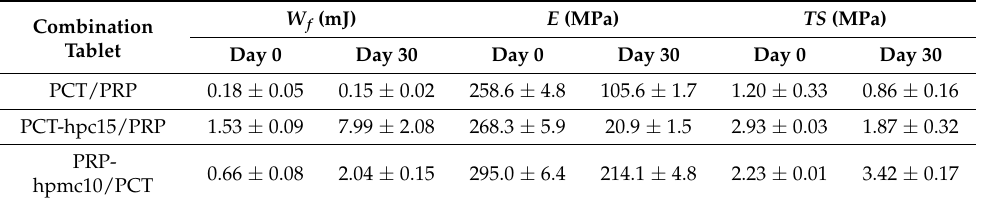
Table 7. Results of fracture test of tablets of optimal combinations: solid fraction, work of failure, Young’s modulus and tensile strength.